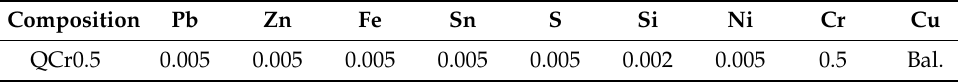
Table 2. Chemical composition and mass fraction of QCr0.5 (wt %).